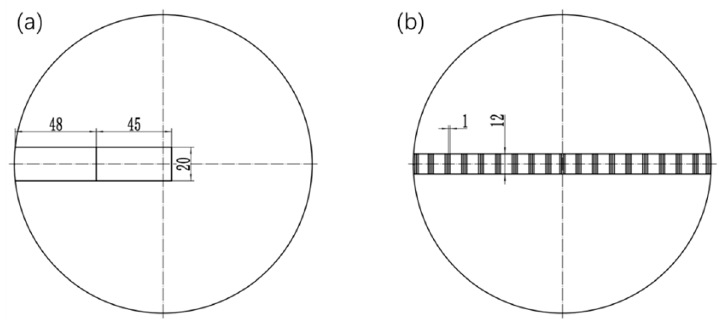
Figure 2. Sampling position of ( a ) microstructure and ( b ) carbon content on cast billet.